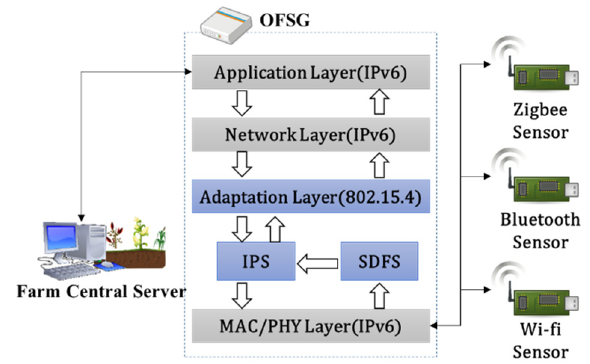
Figure 3. Structure of the optimized farm sensor gateway (OFSG).